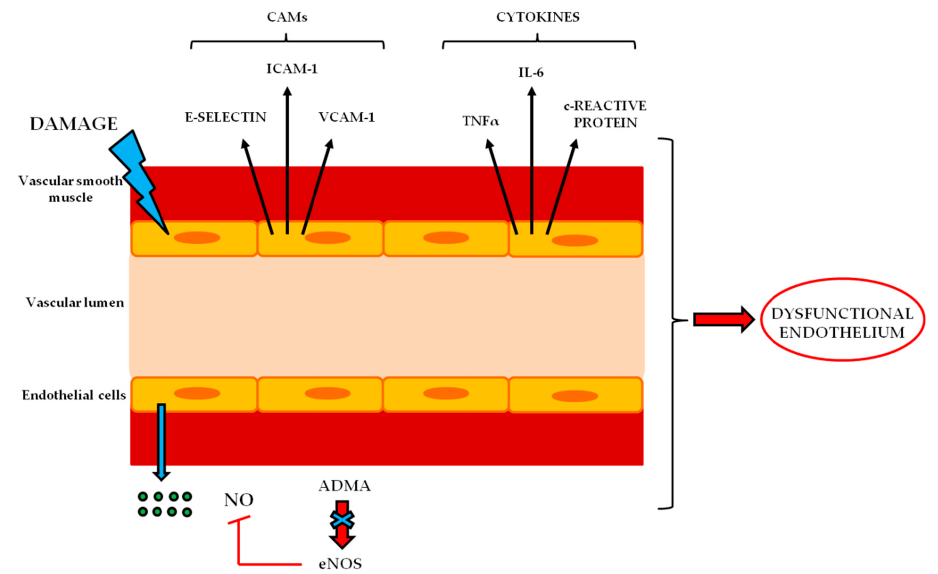
Figure 4. Dysfunction of endothelium. The injury of endothelial cells is accompanied by neuroinflammation due to increased expression of pro-inflammatory factors.